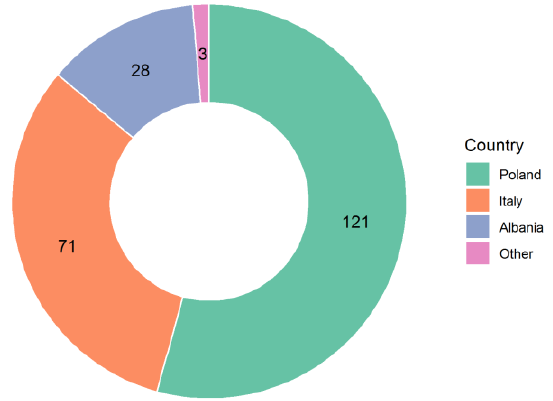
Figure 1. Respondents from different European countries.